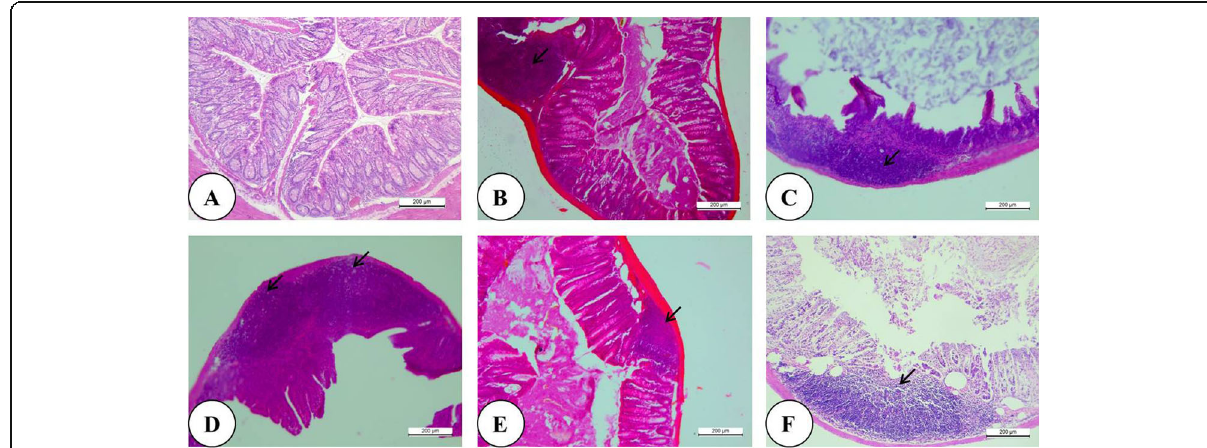
Fig. 6 Histopathology of colon tissue sections stained with hematoxylin and eosin. A NC shows normal colonic mucosa. B PC group with maximum tumoral growth in the 12-week study period. C IRN group showing reduction in tumoral growth. D GT group showing higher tumor growth as compared to the IRN group. E IRN+GT Low group showing decrease in tumor growth as compared to the IRN group. F IRN+GT High group showing decrease in tumor growth as compared to the IRN group along with cellular apoptosis. (arrow head represents area with tumor growth without adenomatous differentiation)